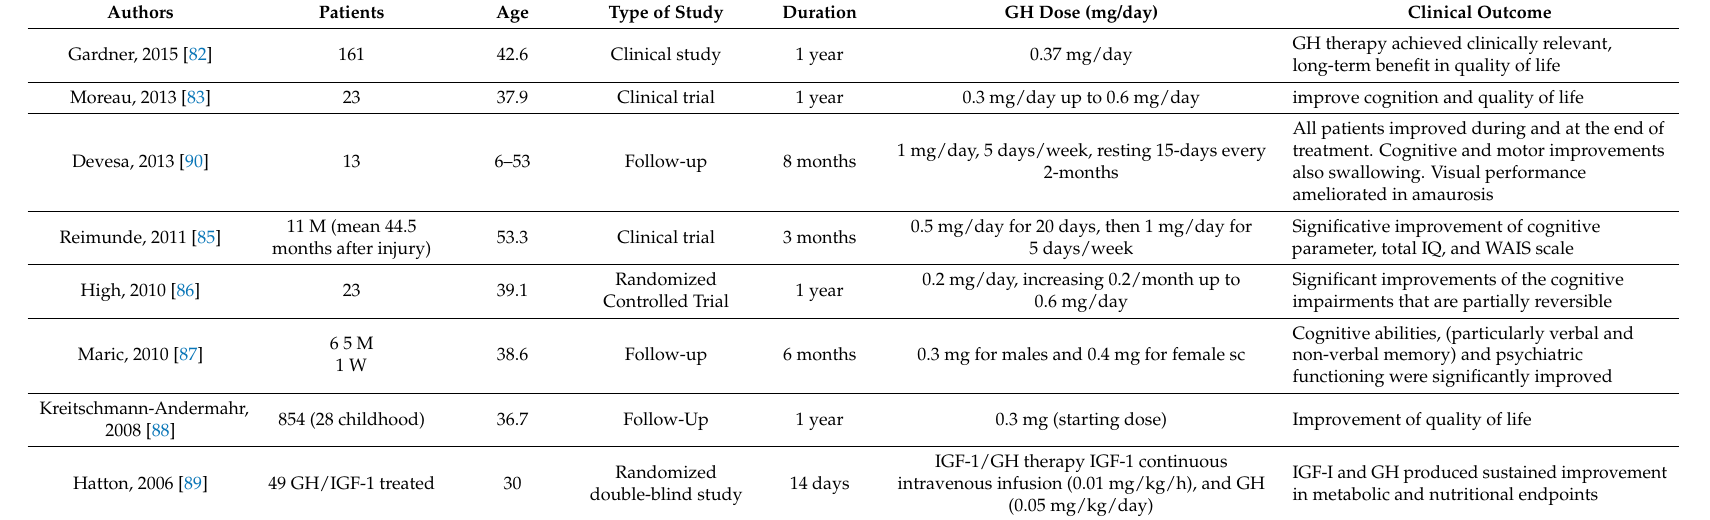
Table 1. Effect of growth hormone (GH) therapy in patients who suffered traumatic brain